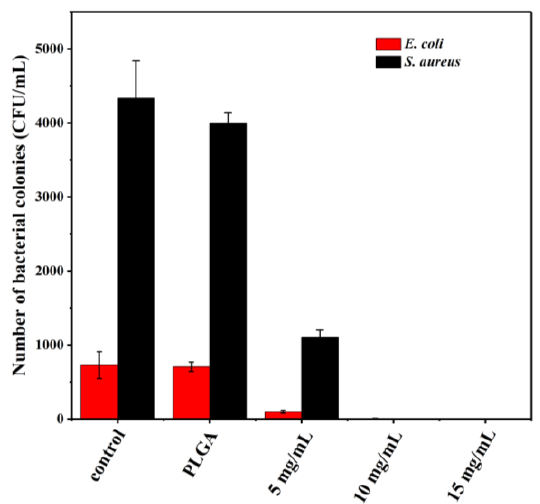
Figure 8. The number of bacterial colonies counted in milk treated with different amounts of thymol-loaded PLGA microparticles (0, 5, 10, and 15 mg/mL). Error bars indicate the standard deviation of the mean.